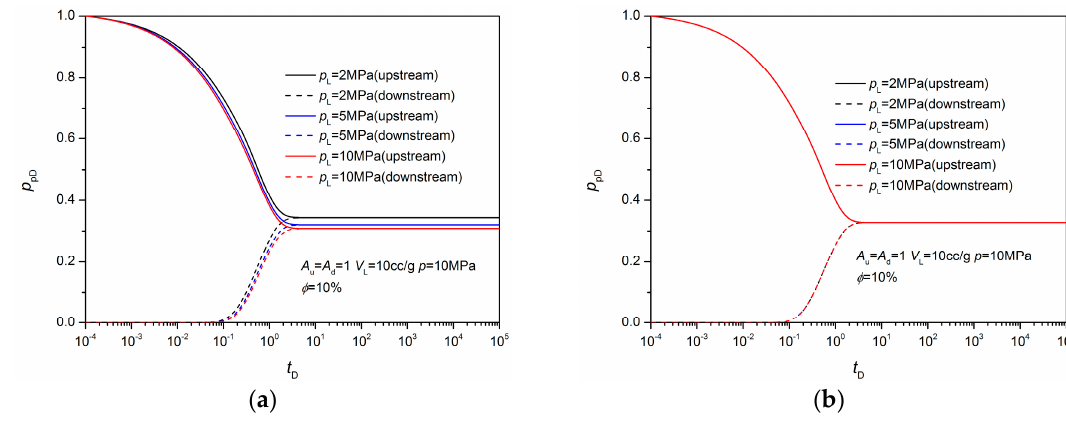
Figure 4. The influence of the Langmuir pressure on the pseudo-pressure curves of the equilibrium sorption model. ( a ) Old dimensionless definition. ( b ) New dimensionless definition.